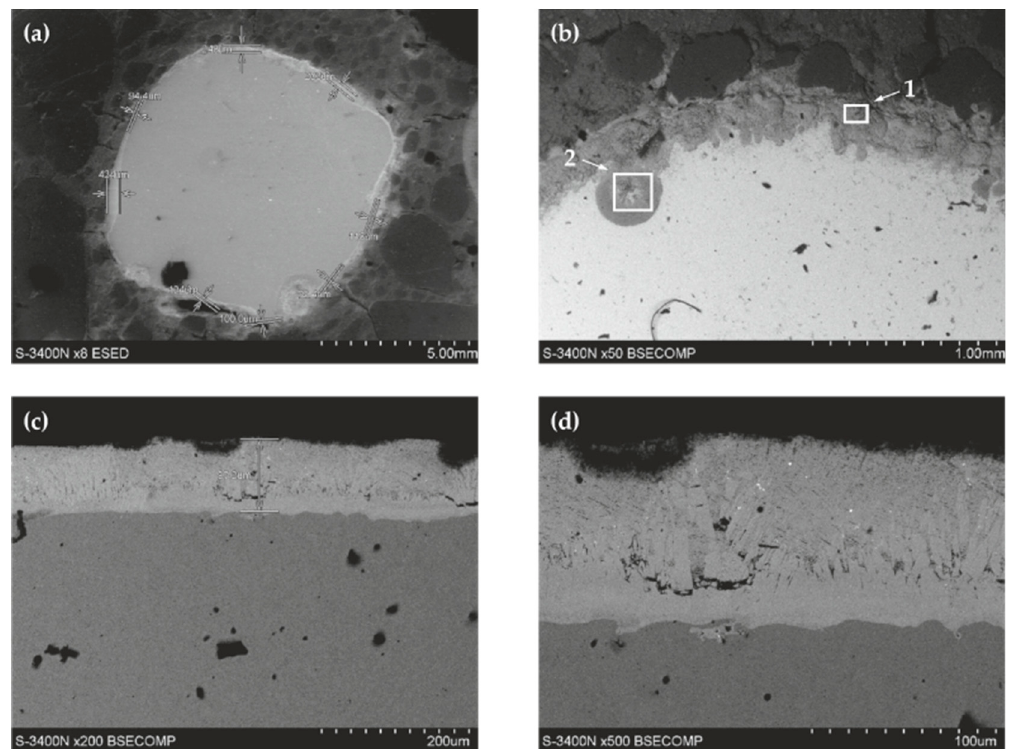
Figure 18. Microstructure of the joint between concrete without chlorides and galvanized reinforcing steel B500SP (SEM): ( a ) general view of a cross-section of a steel bar in concrete ( b ) morphology of the boundary of separation rebar–concrete with marked places 1 and 2 for microanalysis of the chemical composition ( c ) morphology of the zinc coating on the rebar in concrete ( d ) area of the zinc coating with the crack shown in Figure 18c.